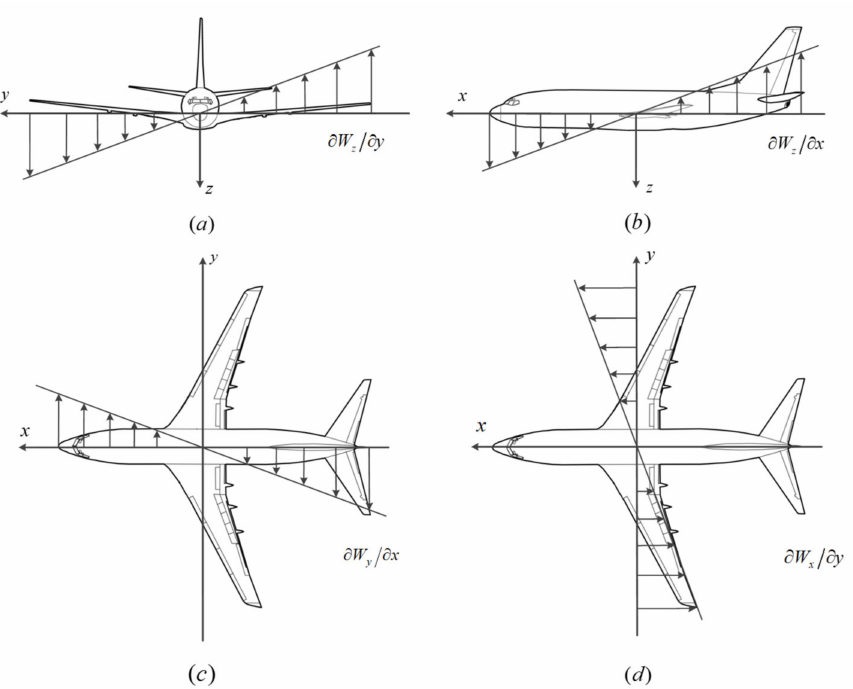
Figure 1. Schematic diagrams for the gradients of the velocity components: ( a ) the gradient of vertical wind speed along the lateral axis. ( b ) the gradient of vertical wind speed along the longitudinal axis. ( c ) the gradient of lateral wind speed along the longitudinal axis. ( d ) the gradient of longitudinal wind speed along the lateral